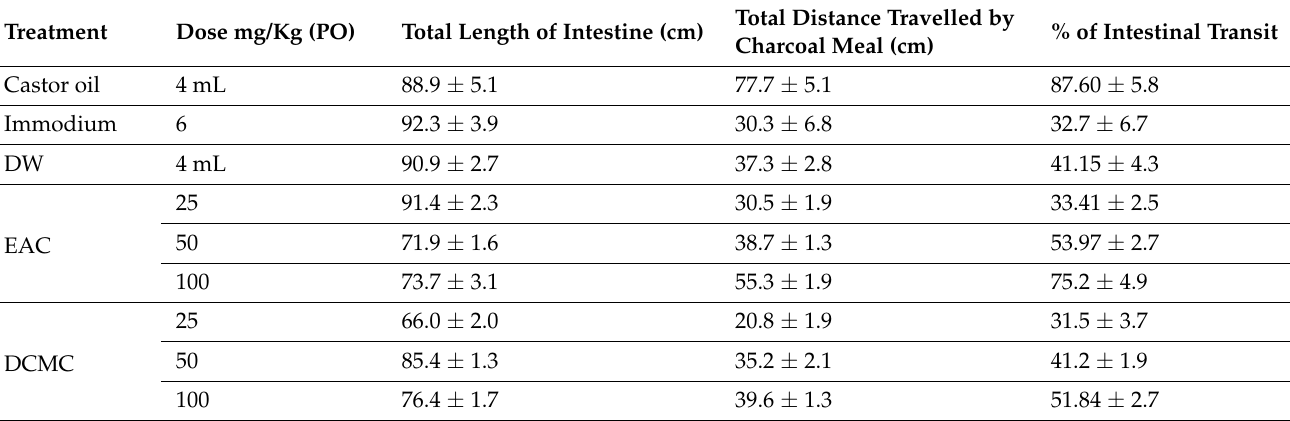
Figure 4. Different concentrations were tested, as shown in the figure; significant results were shown by 3, 5, and 10 mg/kg, with EC 50 equal to 4.71 ± 0.26 mg/kg. In the same way, the 3-, 5-, and 10-mg/kg concentrations of DCMC had a relaxing effect on KCL-induced (80 mM) contraction in rabbit’s jejunum, with an EC 50 value of 5.04 ± 0.05 mg/kg. Table 9. Percent intestinal transit of EAC and DCMC in the pigeons.